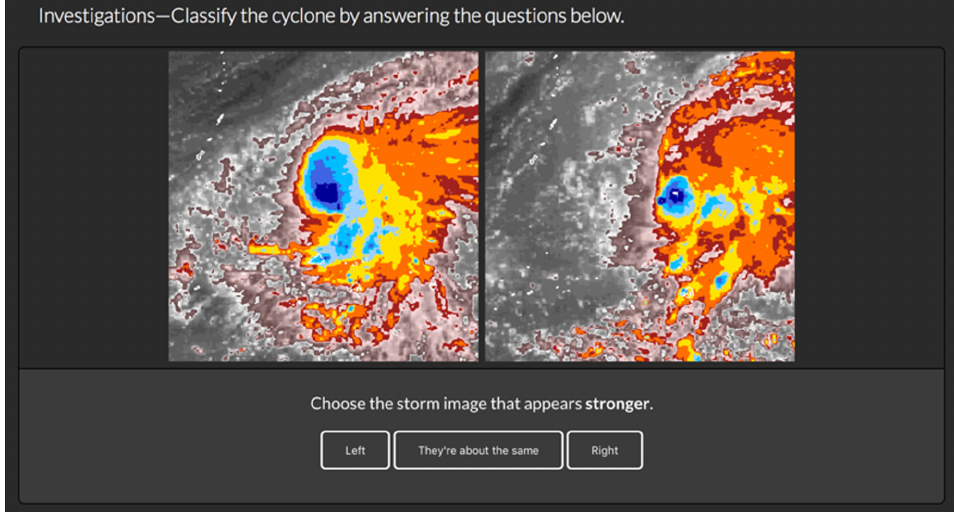
Figure 2: Example of the storm weaker/stronger/same step. Users are presented with two images from the storm 24 hours apart, with the earlier occurrence on the left, and required to decide which is stronger based upon their satellite presentation (cloud top temperatures and organization). In this case, the left hand image would be correctly identi- fied as the stronger of the two, because it shows a greater mass of cold clouds and a greater degree of structure. Users always go on to classify the right-hand image regardless of their